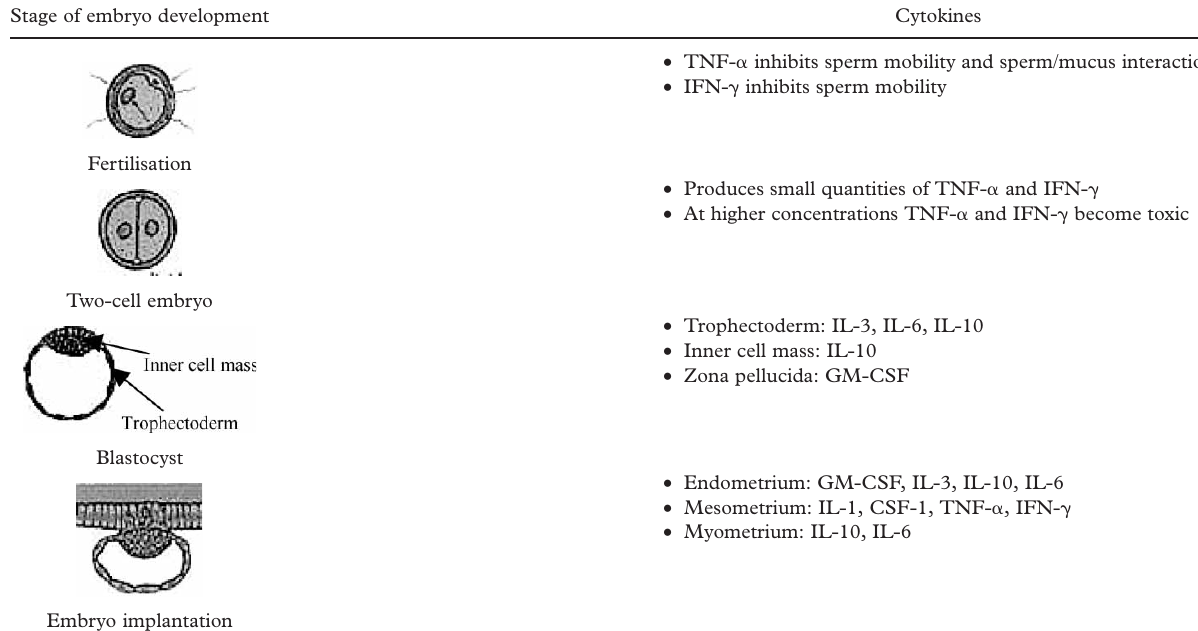
Table I. Cytokine production at different stages of early embryo